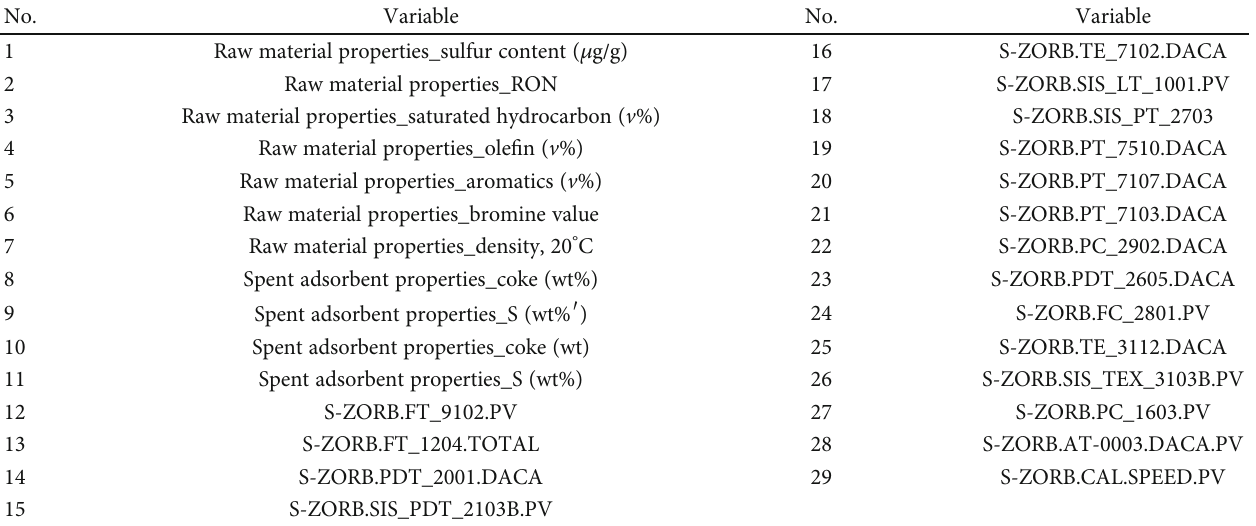
Table 3: Filtered variables of PCA.